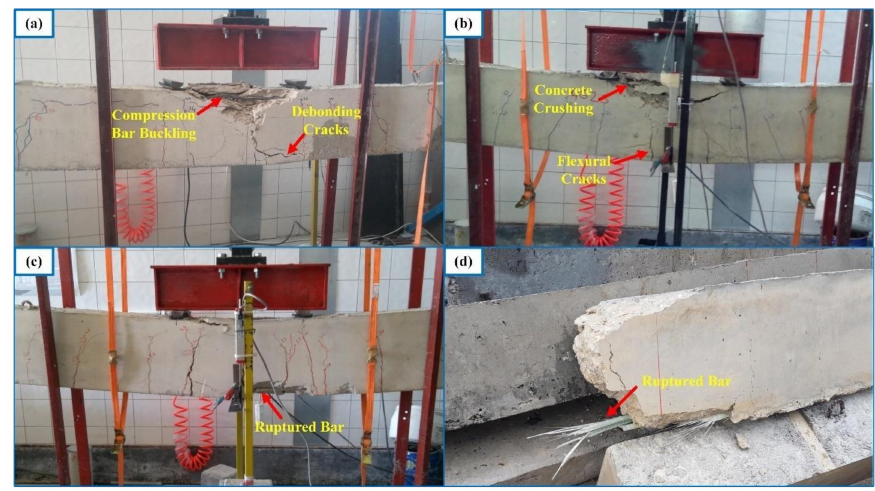
Figure 5. Failure modes of the specimens: compression failure ( a ) in the presence of compression bars; ( b ) in the absence of compression bars; ( c ) tension failure; and ( d ) ruptured bar.